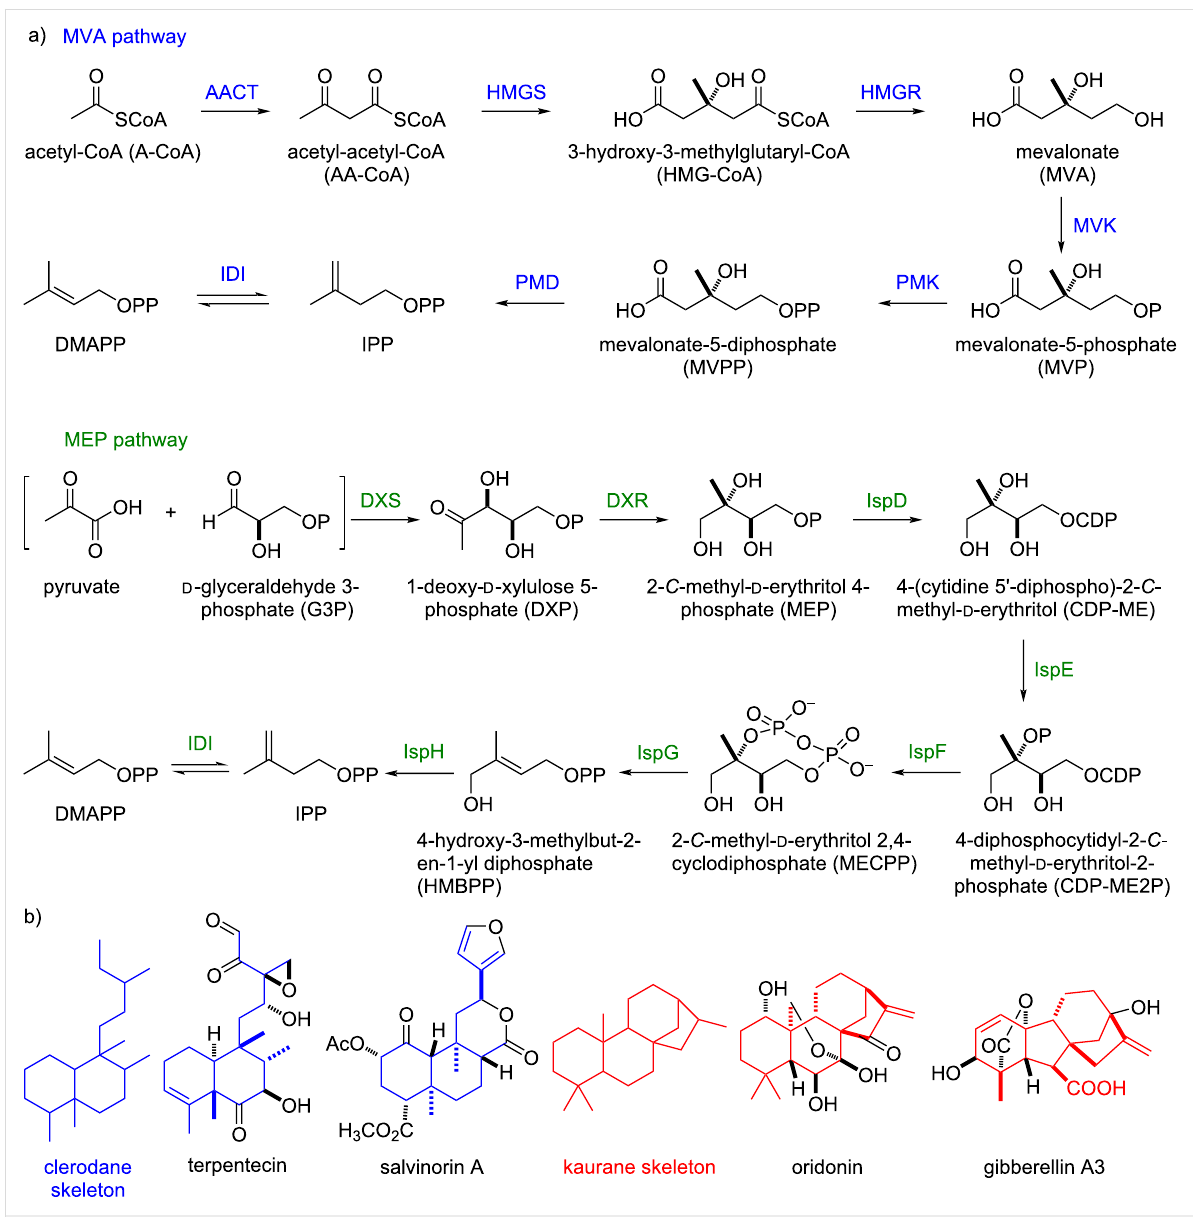
Figure 1: (a) The natural pathways (MVA: blue, MEP: green) for producing IPP and DMAPP; (b) the carbon skeletons of clerodane and kaurane diter- penes and representative bioactive natural products. acetoacetyl-CoA thiolase (AACT); HMG-CoA synthase (HMGS); HMG-CoA reductase (HMGR); mevalonate kinase (MVK); phosphomevalonate kinase (PMK); diphosphomevalonate decarboxylase (PMD); 1-deoxy- ᴅ -xylulose 5-phosphate synthase (DXS); 1-deoxy- ᴅ -xylulose 5-phosphate reductoisomerase